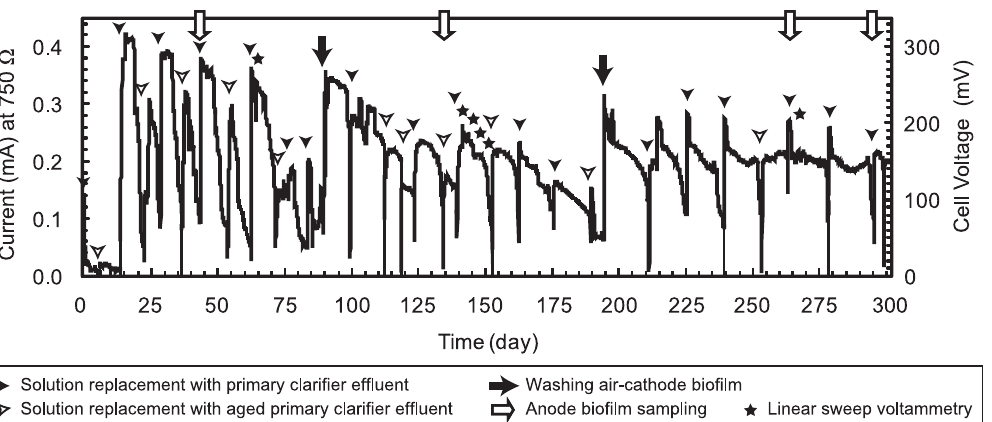
Figure 2. Long-term electricity generation in an air-cathode MFC operating with a 750 V external resistance. Filled arrow, removal of cathode biofilm; Open arrow, anode biofilm sampling for DNA extraction; Filled arrowhead, solution replacement with primary clarifier effluents collected on the same day; Open arrowhead, solution replacement with primary clarifier effluents stored at 4 u C for 5–10 days; Solid star, linear sweep voltammetry to analyze anode performance.